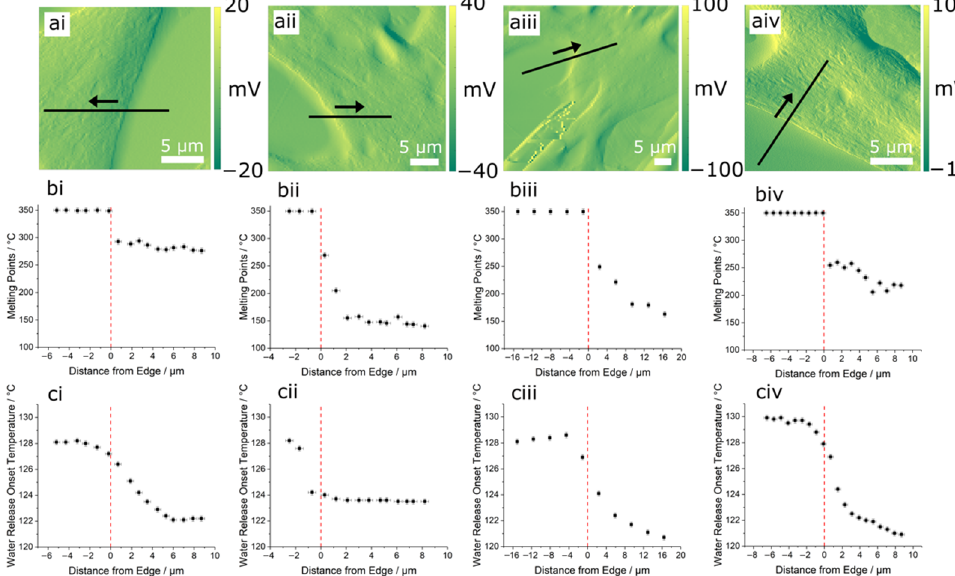
Figure A8. NanoTA analysis of PPB traversing the domain boundary. Each of the columns ( i – iv ) represents a different domain boundary. ( a ) AFM deflection maps where the solid black line denotes the locus of the sampling profile in ( b , c ) and the vertical dotted red line the position of the perceived domain boundary in the image. ‘Low’ and ‘high’ domains can be identified by the greater relative smoothness in the former, as previously indicated. ( b ) changes in the melting point ( c ) water release onset temperature. Uncertainties in the melting points and water release onset temperatures were estimated from uncertainties in determining the deflection maxima and fringe onset in the thermal profiles, respectively.